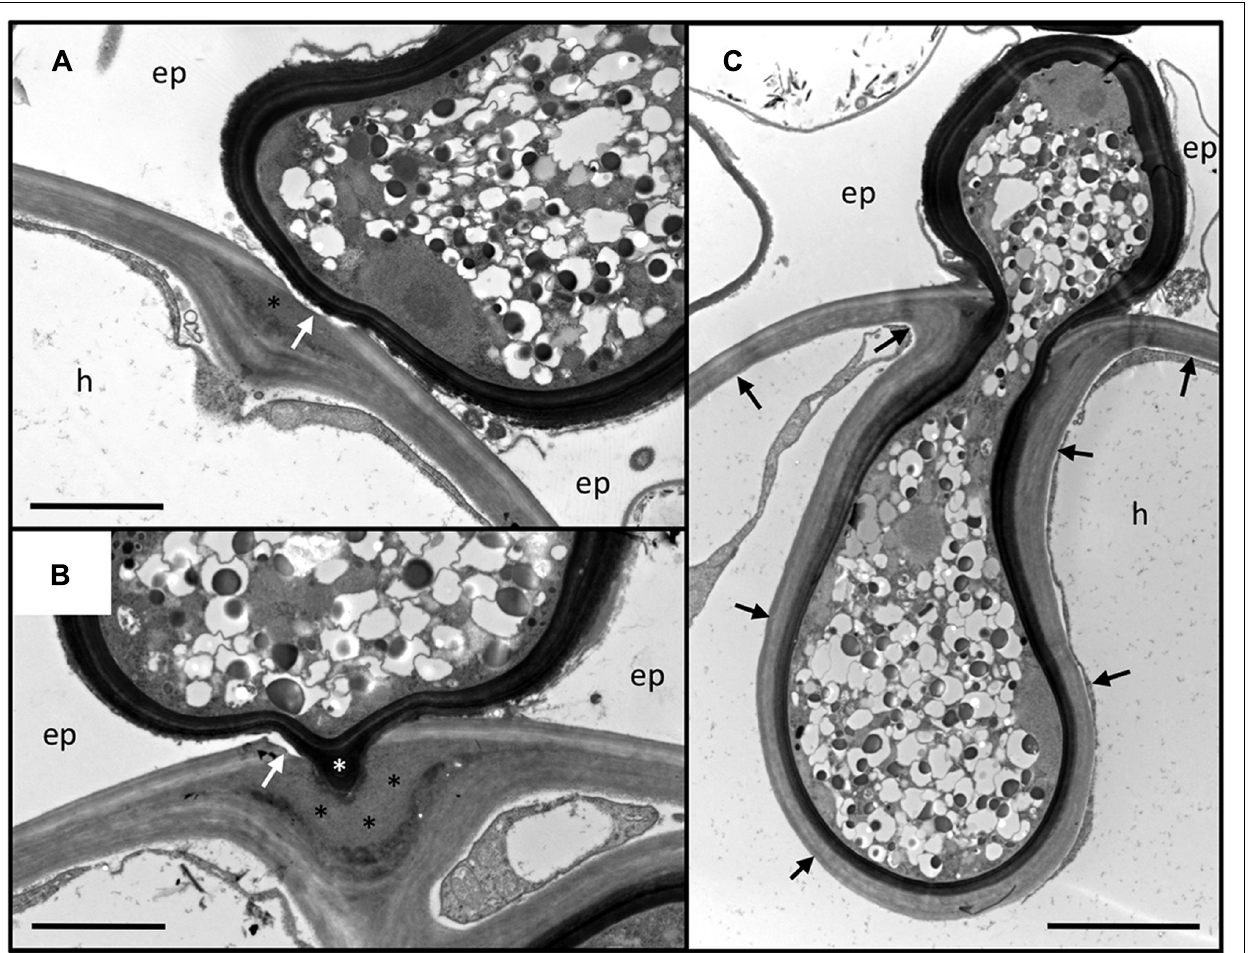
FIGURE 2 | Penetration of the outer root cell layers of Petunia hybrida by Rhizophagus irregularis . Serial sections of an infection site at the level of the hypodermis. (A) Section through the hyphopodium (surrounded by a dark cell wall), that has entered between two adjacent epidermal cells (ep), and attached to a hypodermal cell (h). Note the alterations of the cell wall at the penetration site.The primary wall (light staining) is perforated (white arrow), whereas the secondary wall invaginates into the cellular lumen. In between, an interstitial matrix has been formed (asterisk). (B) Section close to the